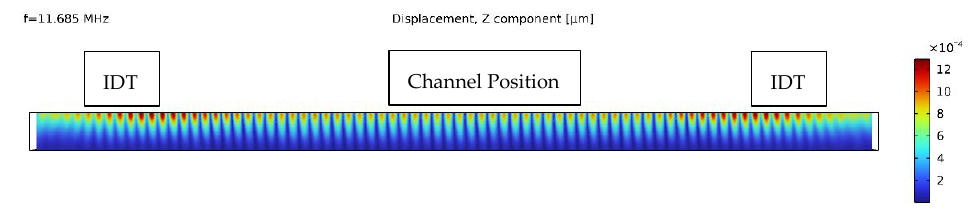
Figure 2. Numerical results in terms of vertical displacement, showing the formation of a standing surface wave. The tags indicate where the components of the device are placed.